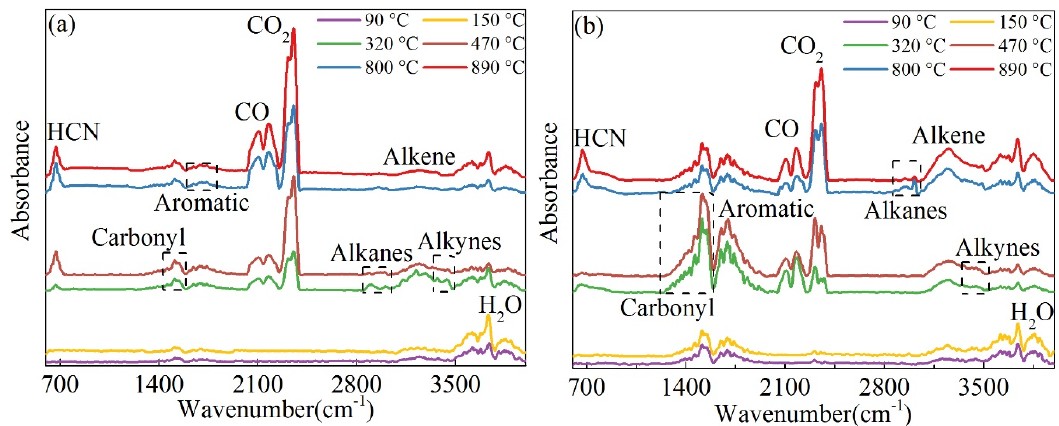
Figure 3. The infrared absorbance spectra of gas products under different stages obtained from ( a ) the sample with 100 wt.% coal and ( b ) the sample with 100 wt.% cyanobacteria.